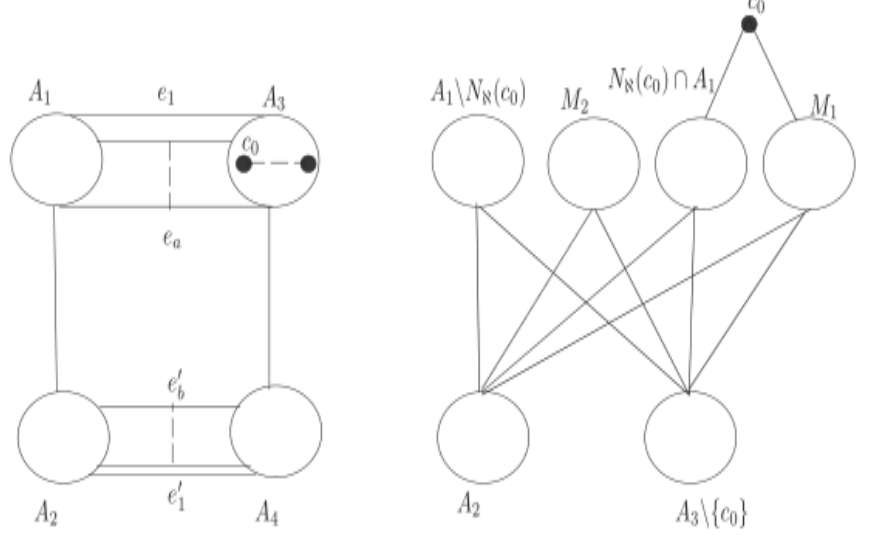
Figure 5. Networks ¯ ℵ and ℵ ∗